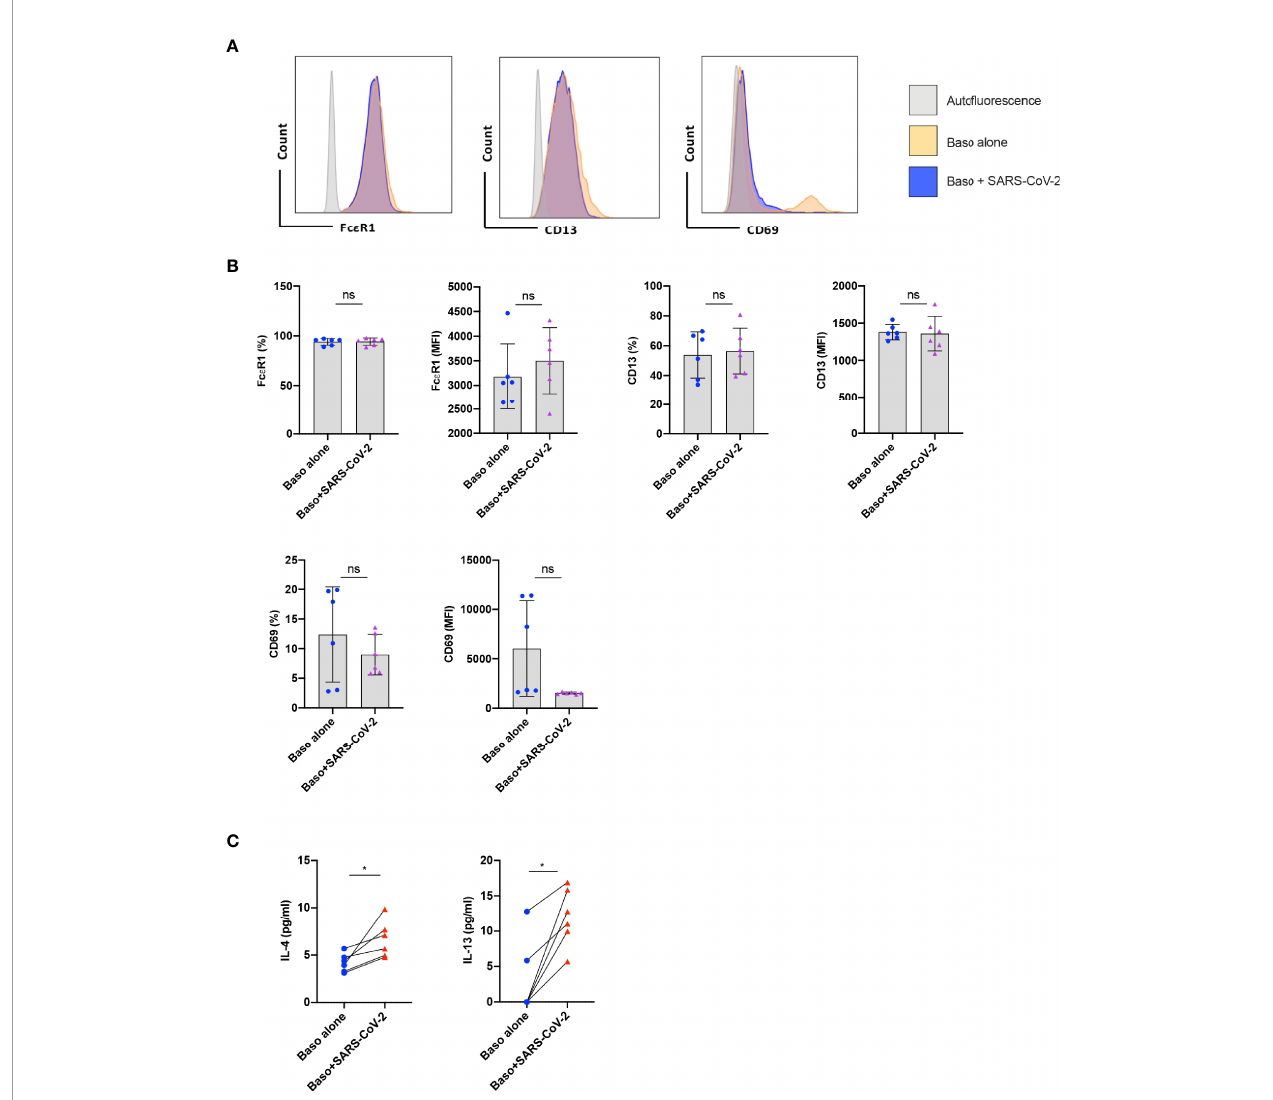
FIGURE 1 | Resting human basophils undergo limited activation upon stimulation with SARS-CoV-2. Basophils (0.1x10 6 cells/100 µl) isolated from PBMCs of healthy donors were cultured with or without SARS-CoV-2 at a MOI of 1. Cell phenotype was evaluated by fl ow cytometry after 24 h. (A) Representative histogram overlays displaying the expression pattern of Fc ϵ R1, CD13 and CD69 on basophils under various experimental conditions. (B) Expression of Fc ϵ R1, CD13 and CD69 on basophils (% positive cells and median fl uorescence intensities (MFI), mean ± SD; n = 6independent donors). (C) The amount (pg/ml) of secreted IL-4 and IL-13 in the cell-free supernatant from the above experiments (mean ± SD, n = 6 independent donors). ns, not signi fi cant, *P < 0.05, paired Wilcoxon